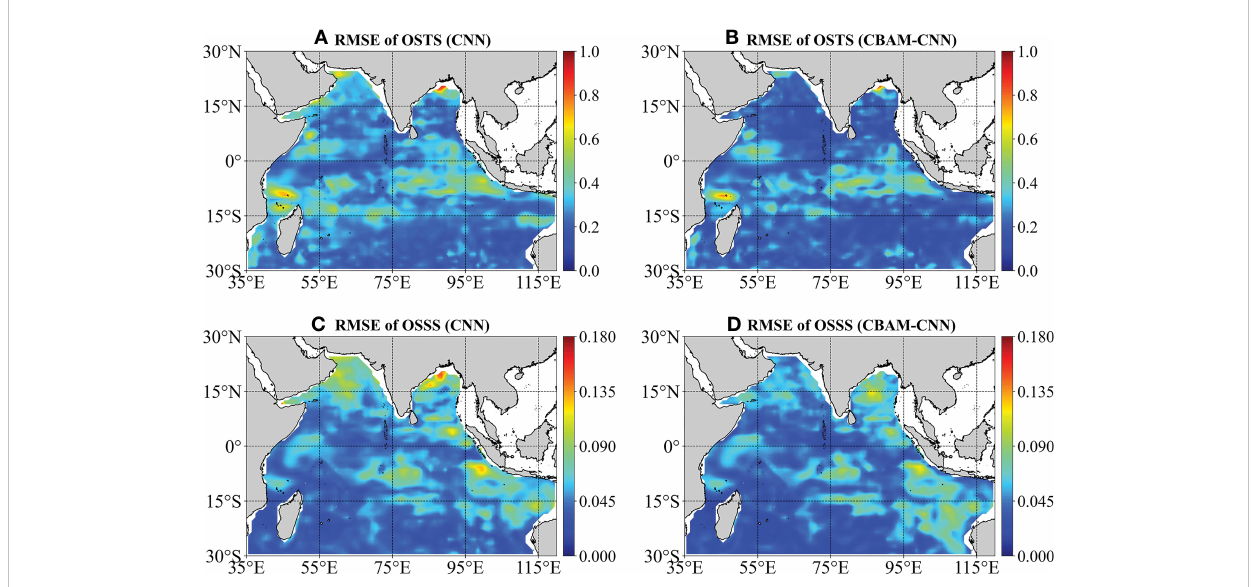
FIGURE 5 Spatial distribution of vertical averaged temperature and salinity RMSE in 2020: (A) CNN and (B) CBAM-CNN models for OSTS, (C) CNN and (D) CBAM-CNN models for